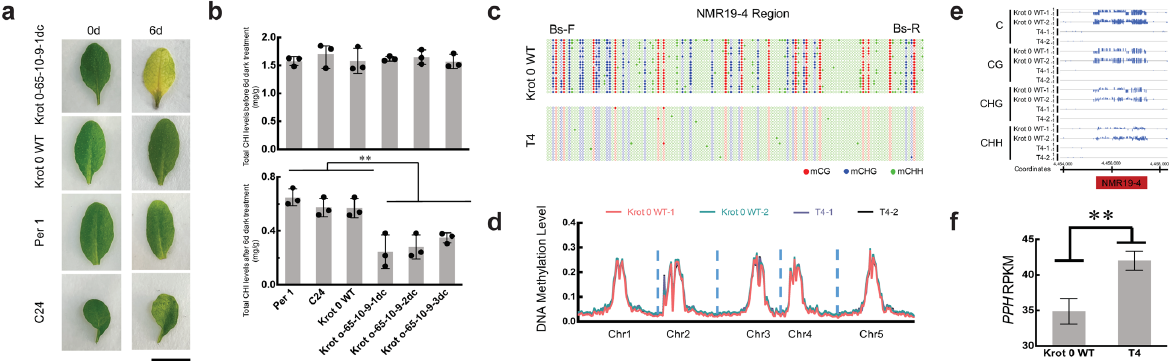
Figure 3. Darkness-induced leaf senescence and methylation status of NMR19-4 in epi-edited progenies. ( a ) Darkness-induced leaf senescence phenotypes in Krot 0-65-10-9-1dc, Krot 0 WT (Krot 0 wild-type), Per 1, and C24. Photos were taken from detached leaves before (0 day) and after 6 days darkness induction. ( b ) Quantification of chlorophyll content before ( top ) and after ( bottom ) 6 days darkness treatment in Per 1, C24, Krot 0 WT, Krot 0-65-10-9-1dc, Krot 0-65-10-9-2dc, and Krot 0-65-10-9-3dc ( n = 3, Black dots represent different repetitions, **, p < 0.01, t -test). Chl represents chlorophyll. ( c ) Bisulfite sequencing analysis of Krot 0 WT (Krot 0 wild type) and T4 generation. The filled circles represent methylated cytosine and the empty circles represent unmethylated cytosine. ( d ) Genome methylation level between Krot 0 WT (Krot 0 wild type) and T4 generation. There are two replications in Krot 0 WT (Krot 0 wild type) and T4 generation. ( e ) Integrated Genome Browser (IGB) snapshot showing methylation variation between Krot 0 WT (Krot 0 wild type) and T4 generation generated from BS-seq data. The blue line indicates the level of methylation. ( f ) RPKM values from RNA-seq data of Krot 0 WT (Krot 0 wild type) and T4 generation ( n = 3, **, p < 0.01, t -test).